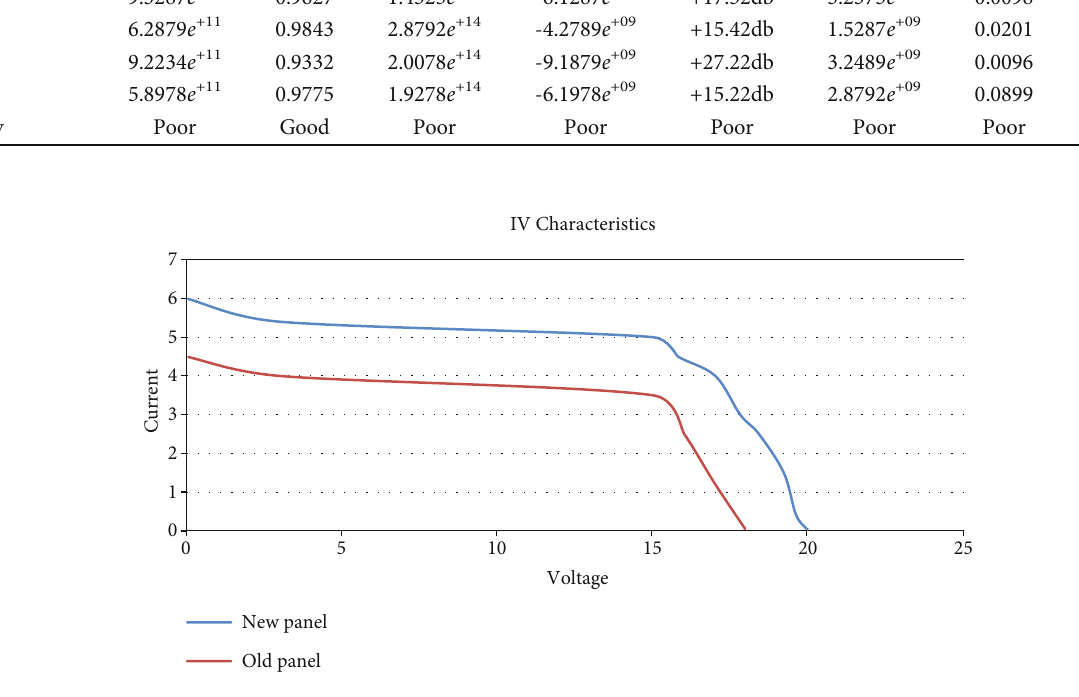
Figure 10: IV characterization of TD1 and bench mark solar